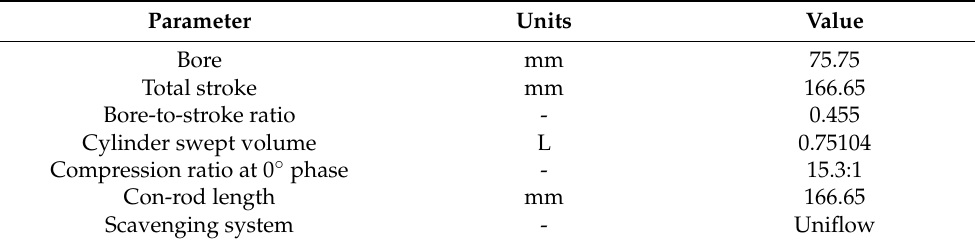
Table 2. Summary of the modelled OP2S engine specifications based on previous work [36,37].